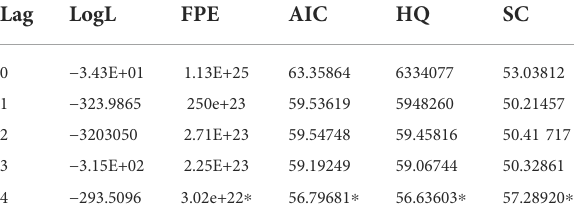
TABLE 4 Results of lag phase number selection. TABLE 5 Lag structure test of VAR